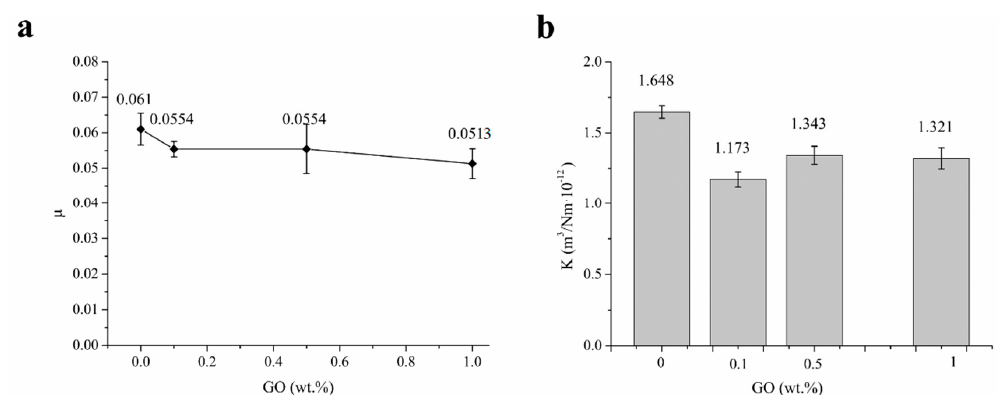
Figure 8. Effect of GO contents on tribological properties of UHMWPE and surface porous GO/NaCl/UHMWPE composites with 10 % NaCl in water, ( a ) the coefficient of friction ( µ ), ( b ) wear ratio ( κ ).